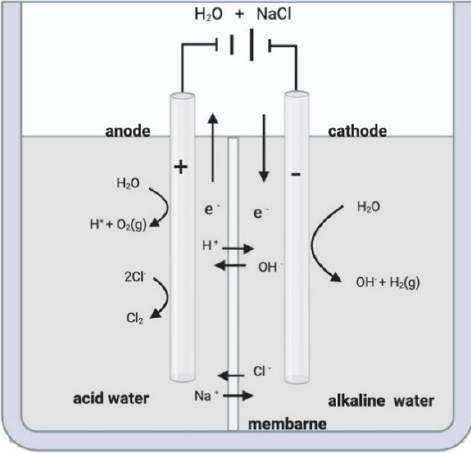
Figure 1. Schematic diagram of electrolyzed water (EW) generation.